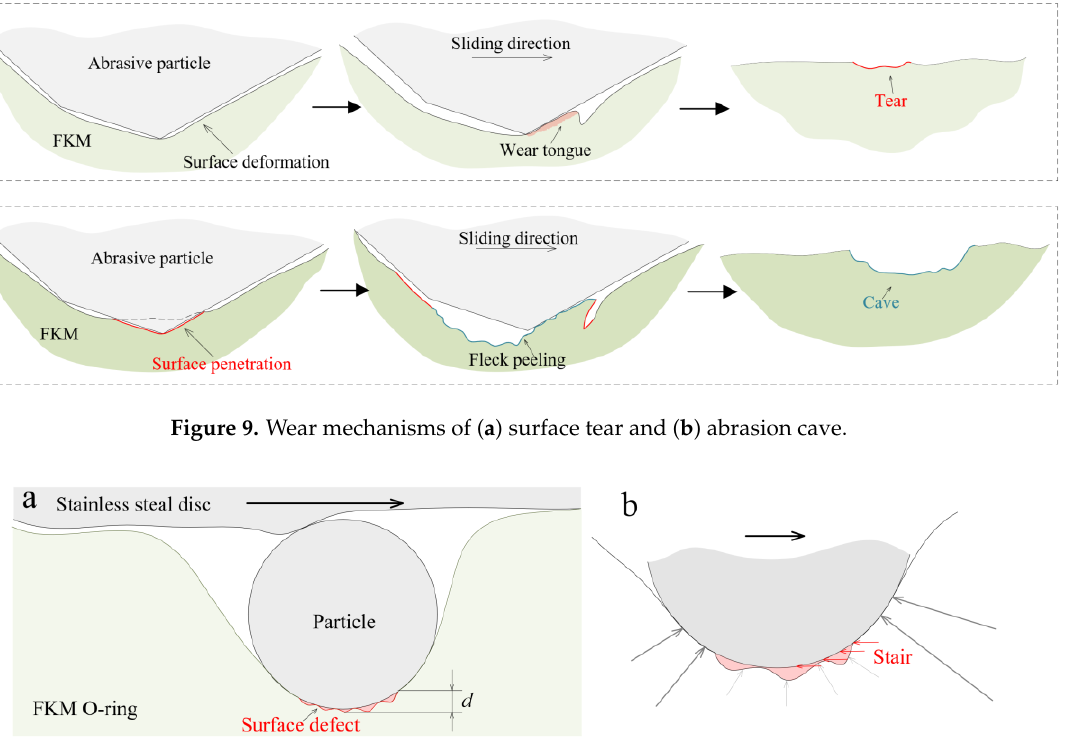
Figure 9. Wear mechanisms of ( a ) surface tear and ( b ) abrasion cave.